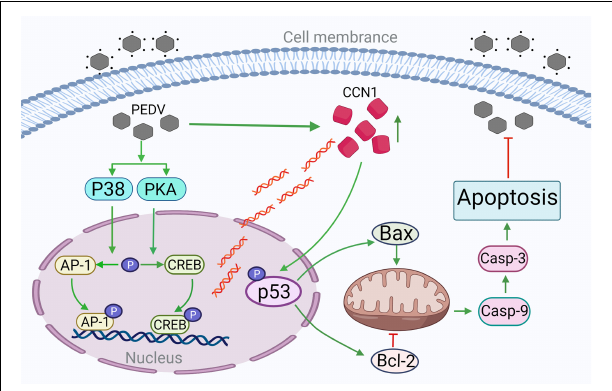
FIGURE 10 | The CREB and AP-1–dependent CCN1 promote PEDV-induced apoptosis through the p53 pathway inhibiting PEDV replication. PEDV infections promote transcription factor CREB and AP-1 phosphorylation, respectively, through PKA and p38 pathways. Phosphorylated CREB and AP-1 binding to CCN1 promoter increase CCN1 expression. CCN1 overexpression increases p53 protein phosphorylation activity. The overexpression of CCN1 promotes Bax expression and inhibits Bcl-2 expression, increases the cleaved of caspase 9 and caspase 3, promotes apoptosis, and inhibits PEDV replication. The addition of p53 inhibitor decreased the occurrence of apoptosis; thus, CCN1 promotes PEDV-induced apoptosis through the p53 pathway. → , activation; ⊥ ,